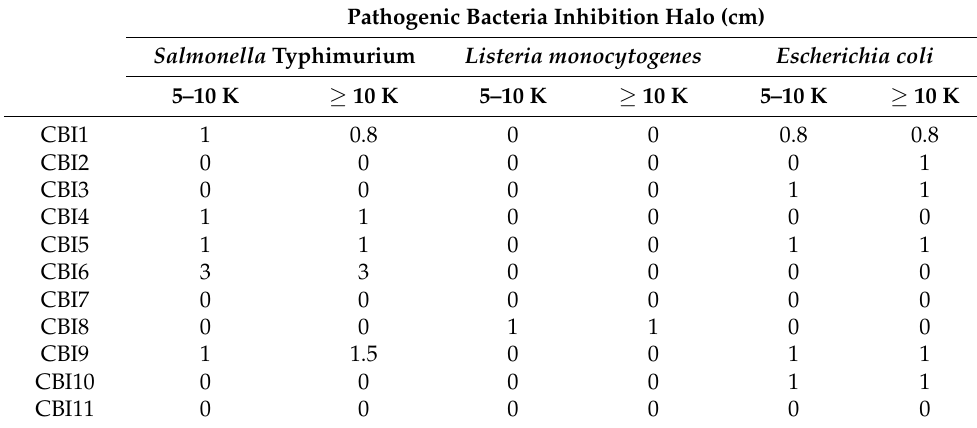
Table 2. Inhibition efficiency of the secondary metabolites against pathogenic bacteria.